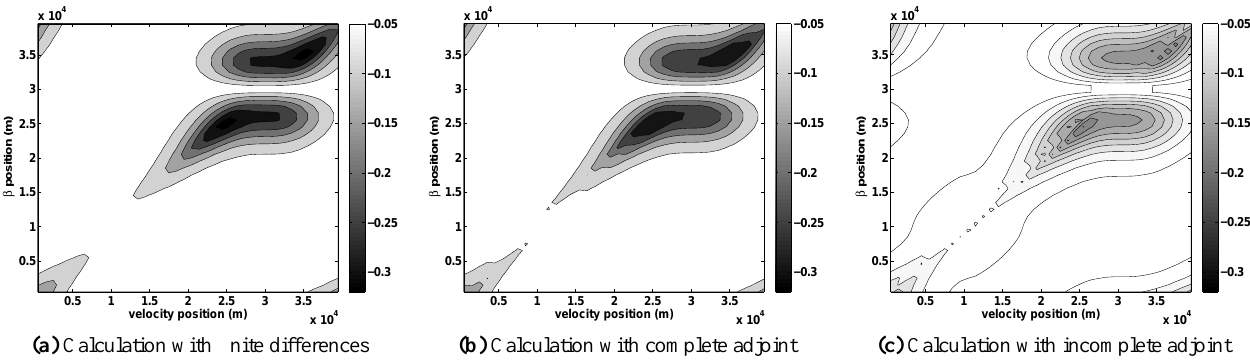
is plotted, where x i is along the horizontal axis and x j the ∂β(x j )